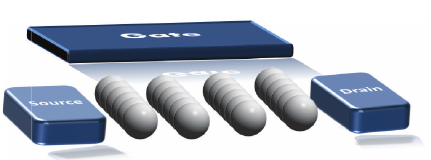
Figure 3: Three planes of 3 × 3 × 3 regular multi-islands